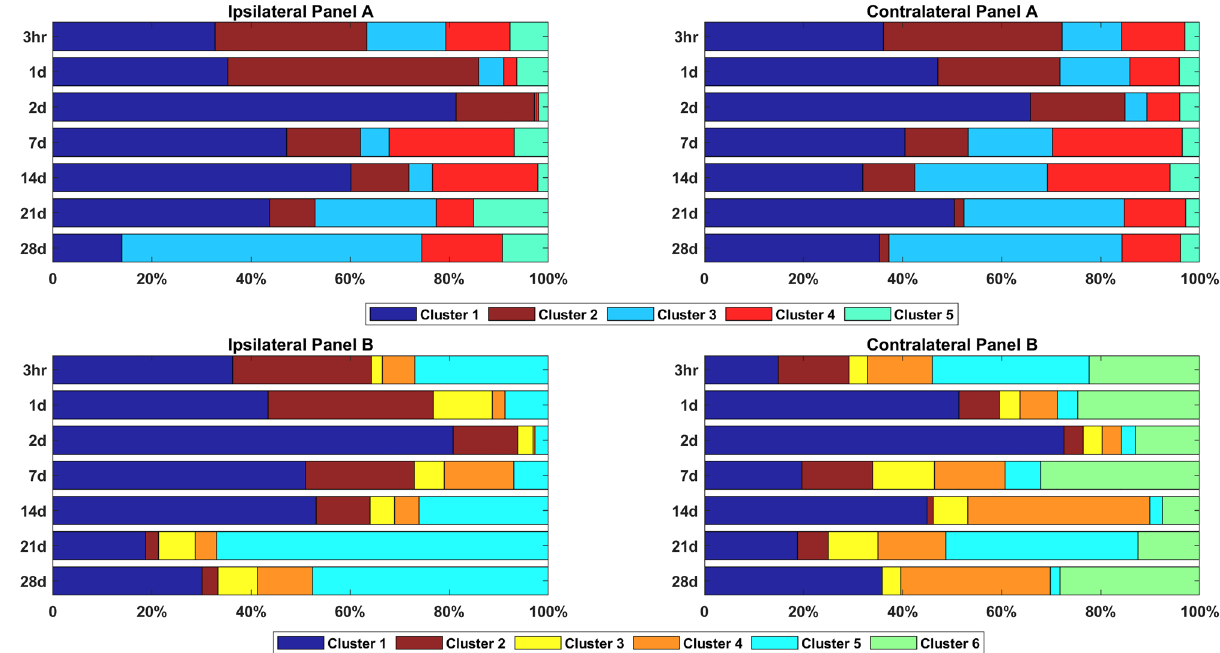
Figure 3. Fraction of cells in each cluster over the seven time points. The fraction of cells in each cluster out of the entire set of cells differentially expressed from sham for ipsilateral clusters and contralateral clusters. Colors denote clusters with similar marker profiles, where clusters 1 and 2 have the same profile (P2Y12 and CD11) across Panel A and Panel